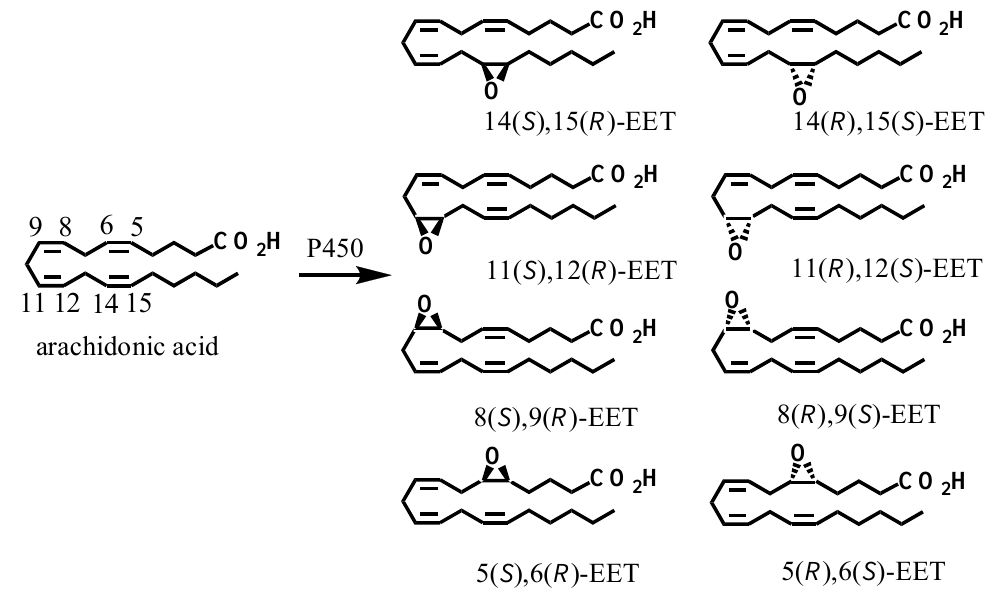
Figure 8. Biosynthesis of epoxyeicosatrienoic acids (EETs) by CYP isoforms. Reprinted with permission from Ref.